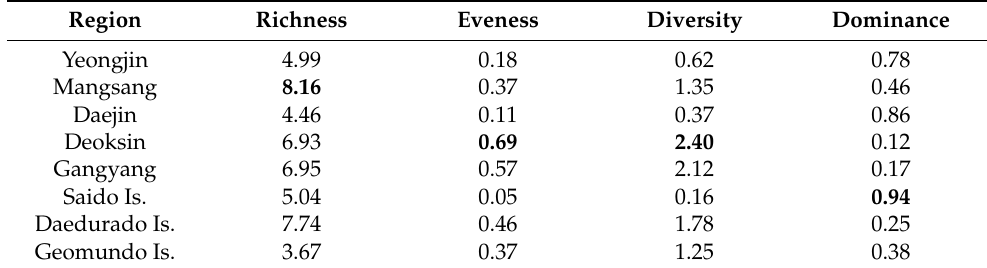
Table 3. Ecological indices of seaweed beds at the study